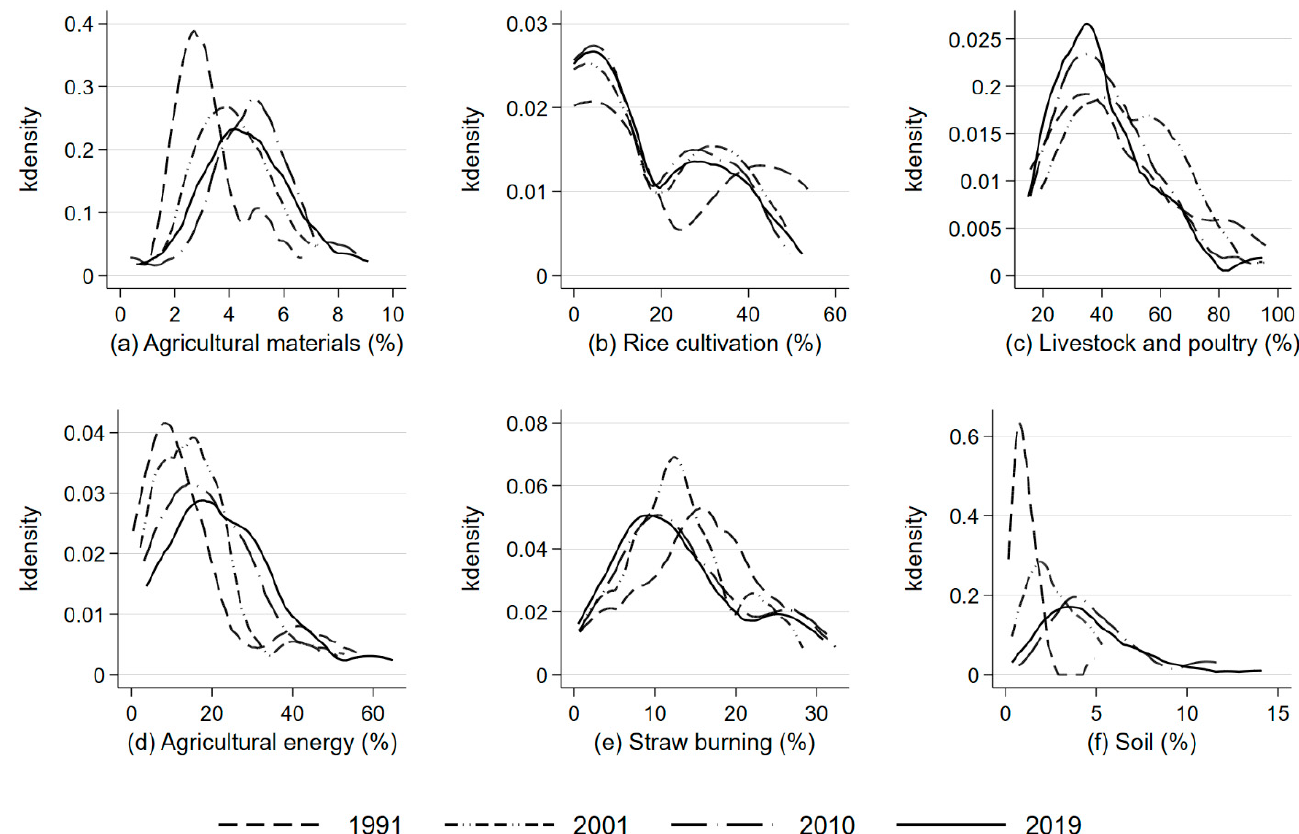
Figure 6. The kernel density estimation analysis of six agricultural carbon sources. The subplot (a)- (f) are the kernel density results of agricultural carbon emissions from agricultural materials, rice cultivation, livestock and poultry, agricultural energy, straw burning and soil, respectively.